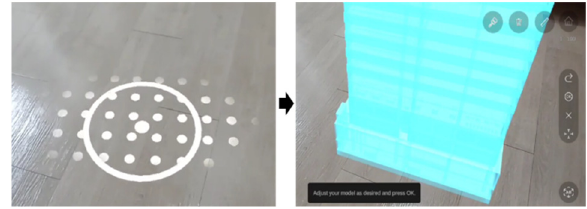
Figure 18. BIM model displayed on screen through floor detection.